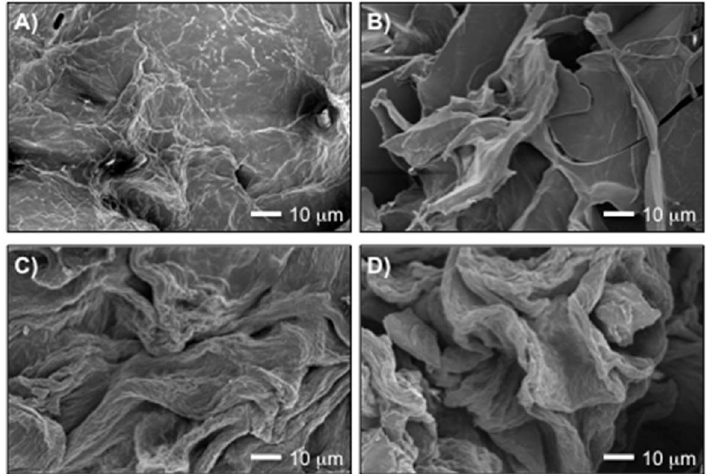
Figure 11. Representative FE-SEM images of xerogels derived from ( A ) pristine gel made of 1b ( c = 7 g/L) in CHCl 3 , ( B ) doped gel made of 1b ( c = 7 g/L) and mandelic acid (molar ratio 1b :acid = 0.1) in CHCl 3 , ( C ) pristine gel made of 1b ( c = 3 g/L) in toluene, ( D ) doped gel made of 1b ( c = 3 g/L) and mandelic acid (molar ratio 1b :acid = 0.1) in toluene.